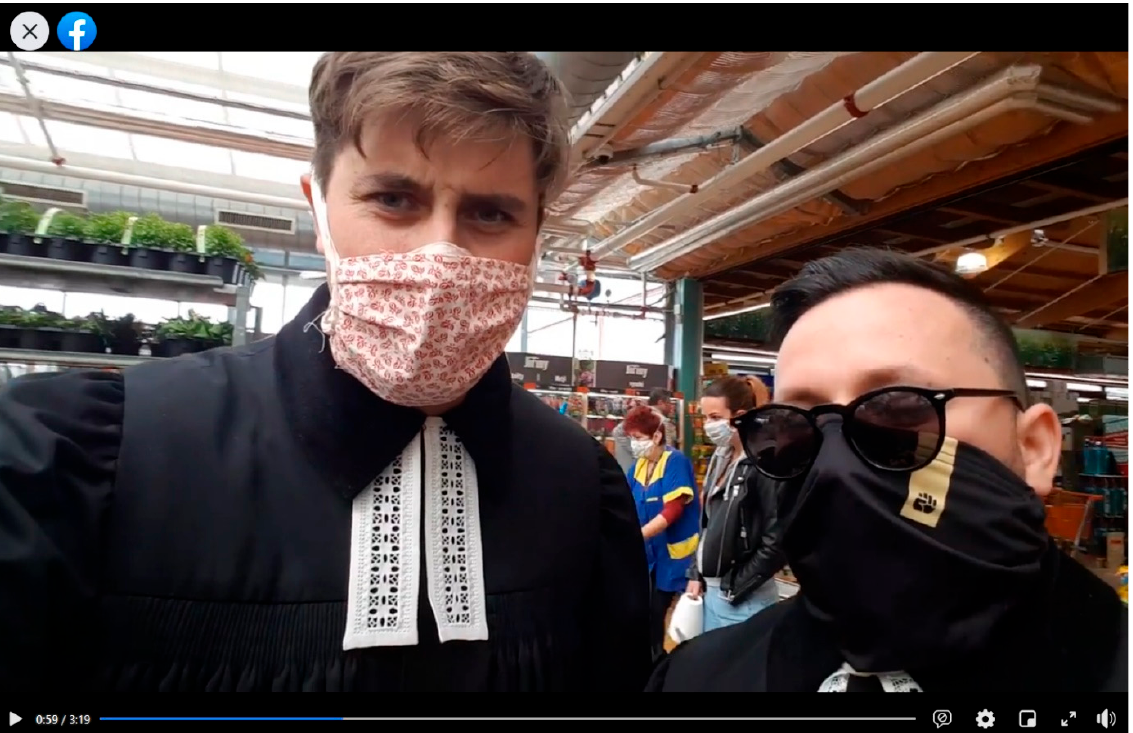
Figure 8. A screenshot from Facebook video of the Czech priestly duo titled ‘Pastoral Brothers’ (19 April 2020). A popular Czech priestly duo Jakub Malý and Karel Müller decided to record a video in an open hobby market as part of their series of funny videos at the time when the churches were closed. The footage shows priests as they explore individual departments in search for items suitable for setting up a mass (candles, statues, pews, chalice, etc.).